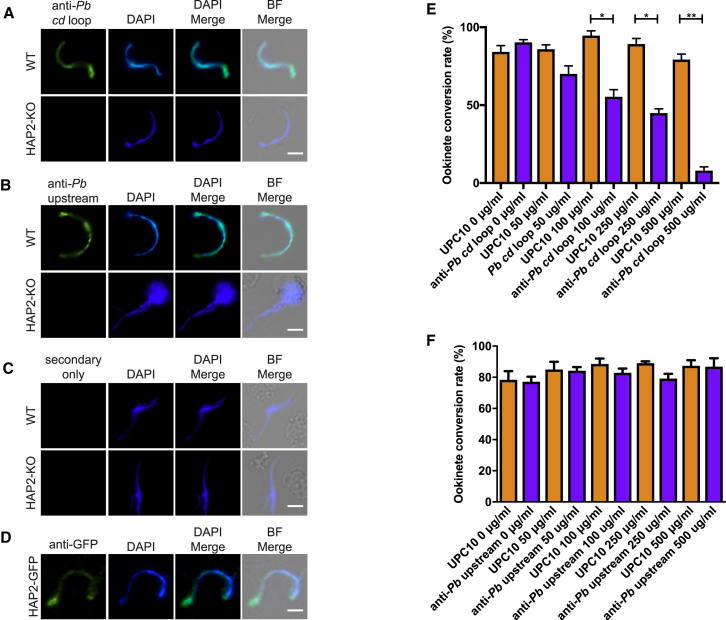
Evaluation of Pb cd Loop and Pb Upstream Antibodies to Inhibit Ookinete Conversion(A and B) IFA of WT P. berghei ANKA and P. berghei HAP2-KO male gametes with (A) anti-Pb cd loop and (B) anti-Pb upstream.(C) Secondary-only control antibodies (green) DAPI (blue).(D) IFA of HAP2-GFP male gametes with anti-GFP shows a similar staining pattern to that obtained using anti-Pb cd loop and anti-upstream antibodies. Scale bars, 5 μm.(E and F) In vitro ookinete development assays with anti-Pb cd loop (E) and anti-upstream (F) antibodies compared to negative control antibody UPC10 at concentrations of 0, 50, 100, 250, and 500 μg/mL. ∗p value < 0.05 paired t test. Error bars indicated SEM within individual samples.